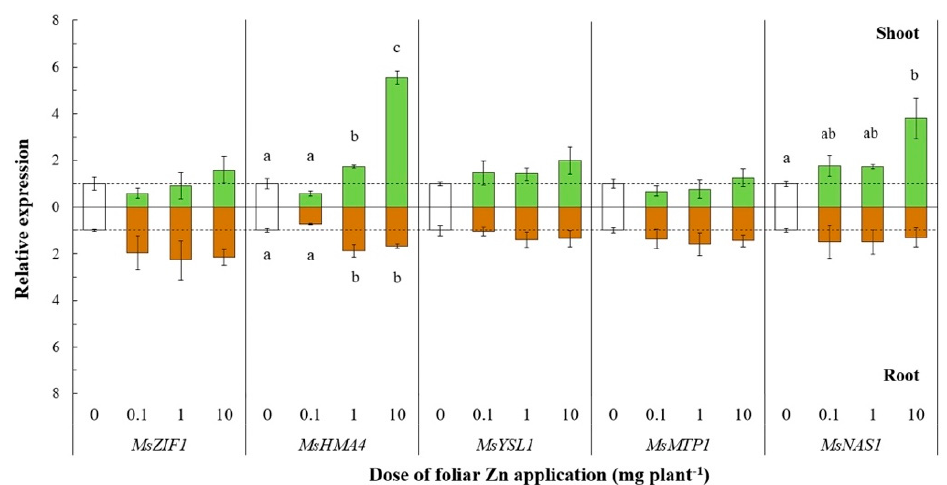
Figure 4. Relative expression of genes related to Zn transport processes after leaf Zn application to alfalfa. The Zn doses were 0, 0.1, 1, or 10 mg Zn plant − 1 . Means ± standard error of three replicates are shown. The expression levels were calculated relative to reference genes ( MsACT-101 for shoot and MsEF1- α for root) and to the control (0 mg Zn plant − 1 ). The broken line denotes the threshold between up- and downregulation relative to the control. Differences in the expression of each gene at the different Zn doses were tested separately for shoot and root by one-way analysis of variance. Different letters denote significant differences among Zn doses, according to Tukey-B test ( p < 0.05).